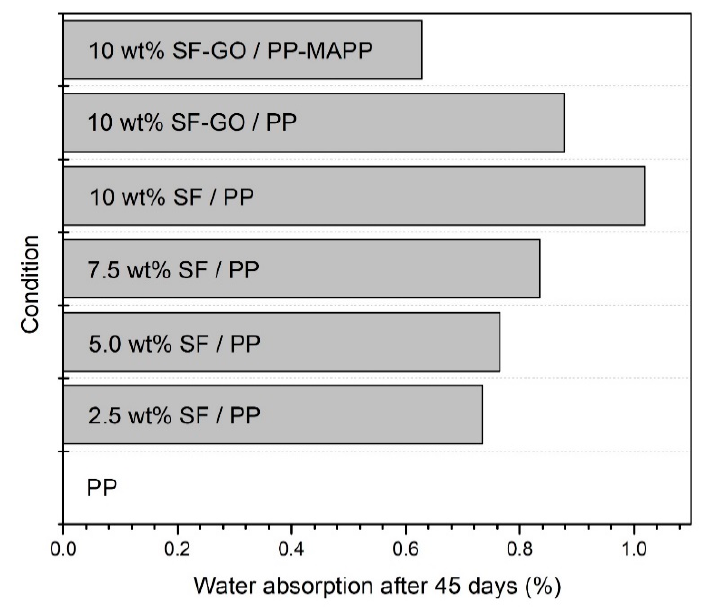
Figure 13. Water absorption of different sisal/PP composites after 45 days. Adapted from [53].